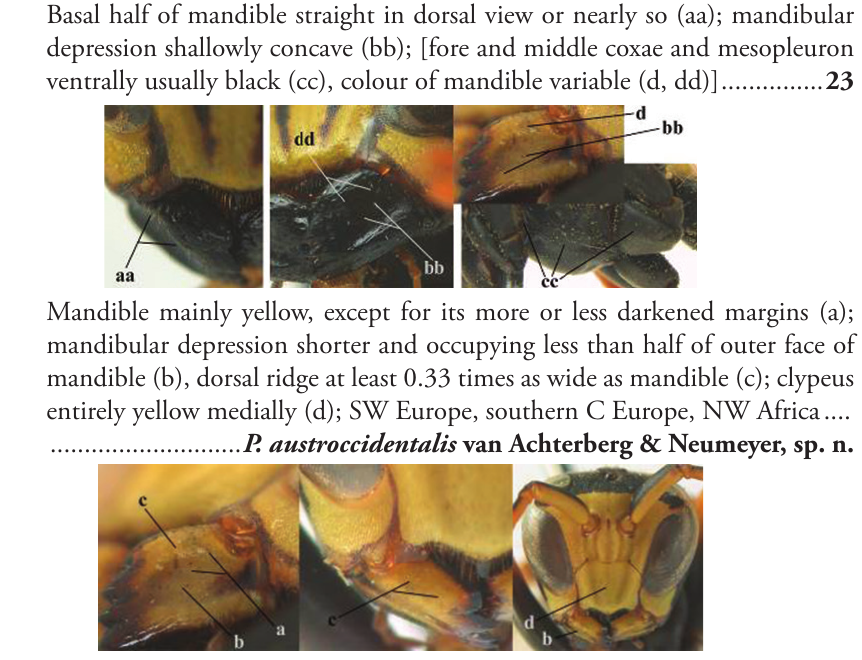
– Mandible black (aa), rarely with small yellow spot; mandibular depression wide and occupying most of outer face of mandible (bb), dorsal ridge 0.25–0.30 times mandibular width (cc); clypeus medially with dark brown pattern (dd), but sometimes largely reduced or absent; S Europe and southern C Europe to W Asia. [If from Morocco consider P. maroccanus (male